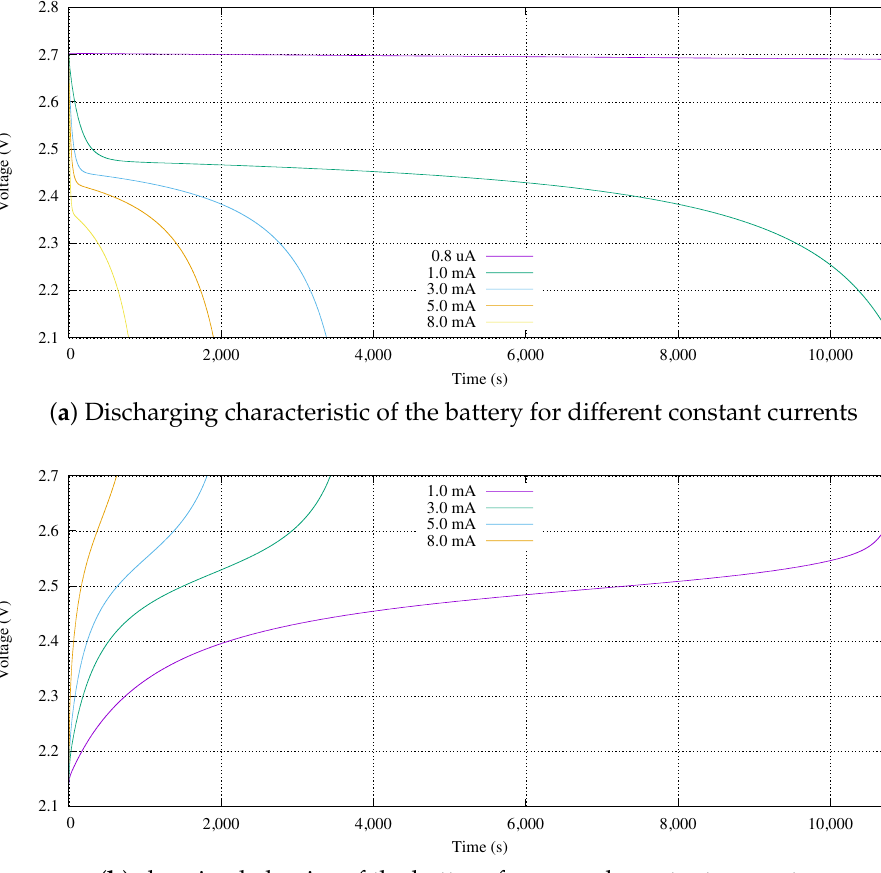
( b ) charging behavior of the battery for several constant currents Figure 6. Voltage behavior of a 3 mAh battery.